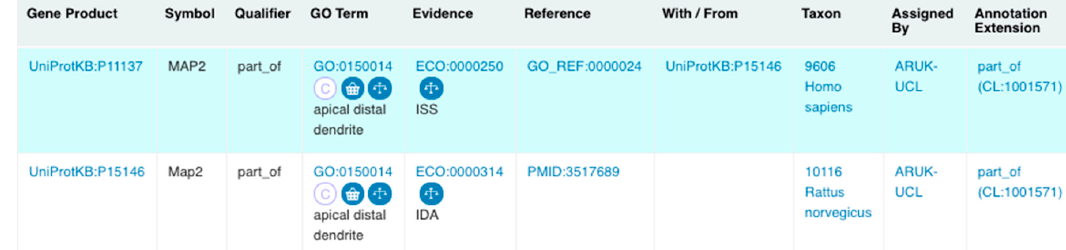
Figure 6. Rat Map2 and human MAP2 GO annotations to ‘apical distal dendrite’ (GO:0150014)